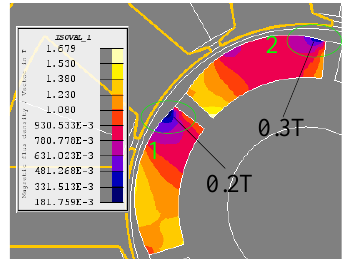
Figure 11. Magnetic density cloud map when armature current is 150